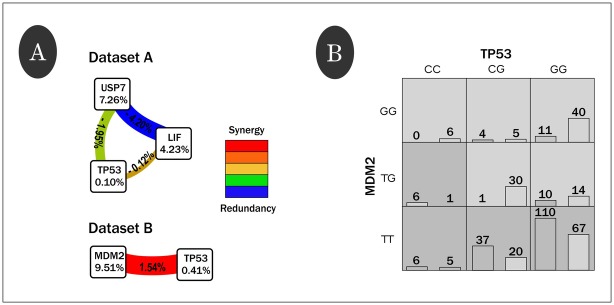
Summary of the multifactor dimensionality reduction (MDR) interaction models.
(A) Interaction graphs comprised of nodes with pairwise connections between them. Values in nodes represent information gain (IG) of individual genes (main effect), while values between nodes are the IG of each pairwise combination (interaction effects). Positive entropy (plotted in red) indicates interaction (epistasis) and negative entropy (plotted in green or blue) indicates redundancy. Independence is represented by the gold color. (B) The MDM2-TP53 interaction associated with altitude in data set B. High-frequency genotype combinations in individuals who inhabit highlands (≥ 2,500 meters) are depicted as darkly shaded cells and low-frequency combinations in those individuals as lightly shaded. For each cell, the left bar indicates the absolute number of individuals who inhabit highlands and the right bar the absolute number of individuals who inhabit lowlands (< 2,500 meters).